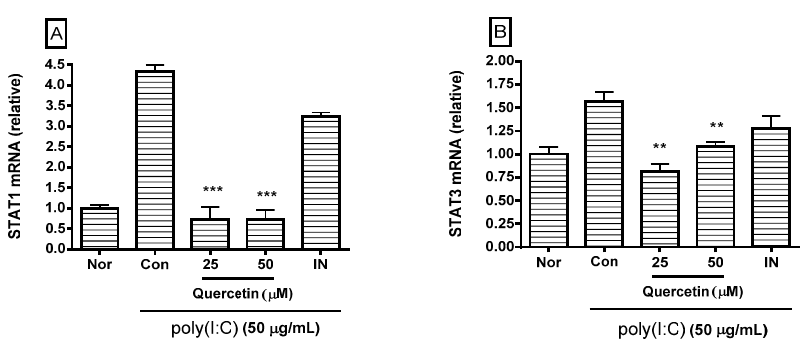
Figure 4. Effect of quercetin on signal transducer and activated transcription 1 (STAT1) ( A ) and STAT3 mRNA expression ( B ) in dsRNA-induced RAW 264.7 mouse macrophages. After an 18 h treatment, STAT1 and STAT3 mRNA expression was measured by real-time reverse-transcription polymerase chain reaction assay. STAT1 and STAT3 mRNA were normalized to GAPDH mRNA. The normal group (Nor) was treated with media only. The control group (Con) was treated with 50 µ g/mL of the dsRNA synthetic analog polyinosinic-polycytidylic acid (poly(I:C)) alone. IN, indomethacin (0.5 µ M). Values are the mean ± standard deviation of three independent experiments. ** p < 0.01 vs. Con; *** p < 0.001. Significant differences were examined using one ‐ way analysis of variance test followed by Tukey’s multiple comparison test.